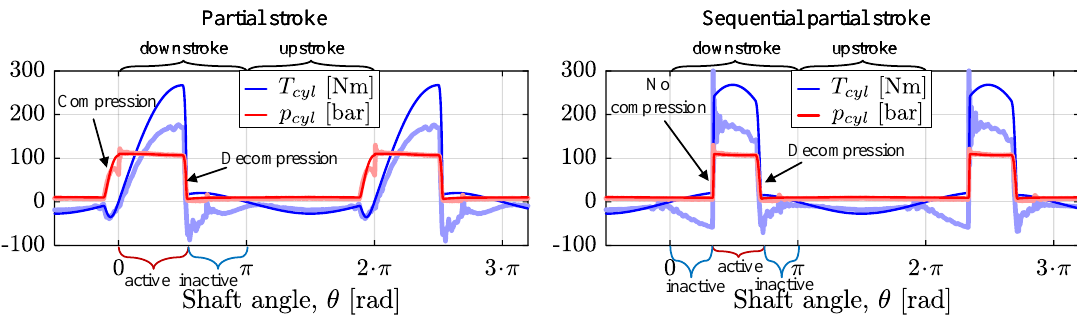
Figure 15. Experimental and simulated results for partial stroke and sequential partial stroke motor operation (light color is experimental results, and dark color is simulation